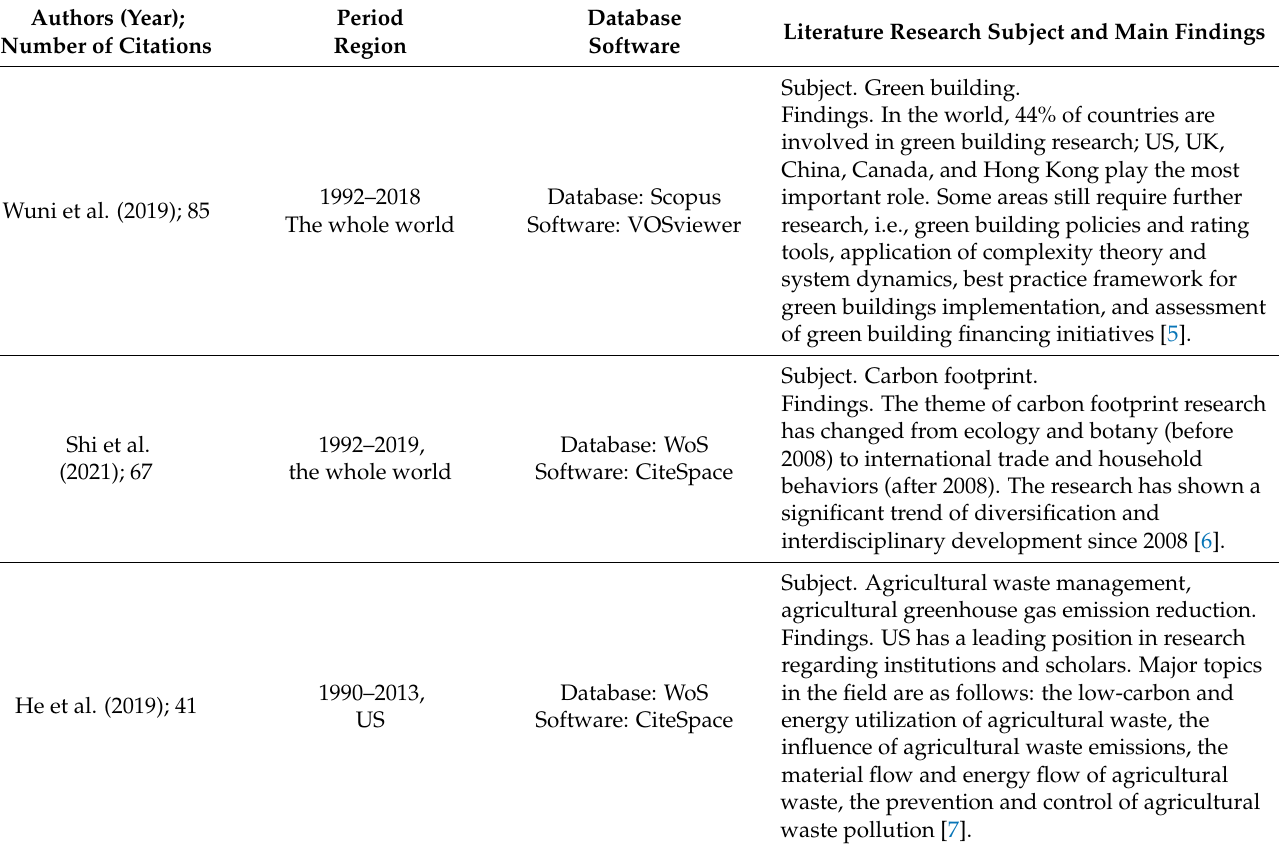
Table 1. The summary of the literature